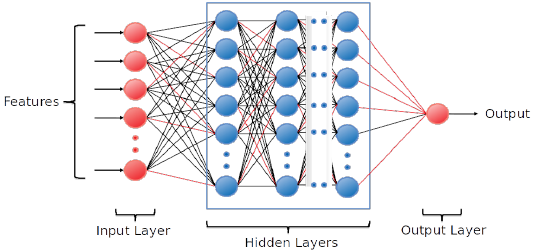
Figure 2. An artificial neural network with multiple hidden